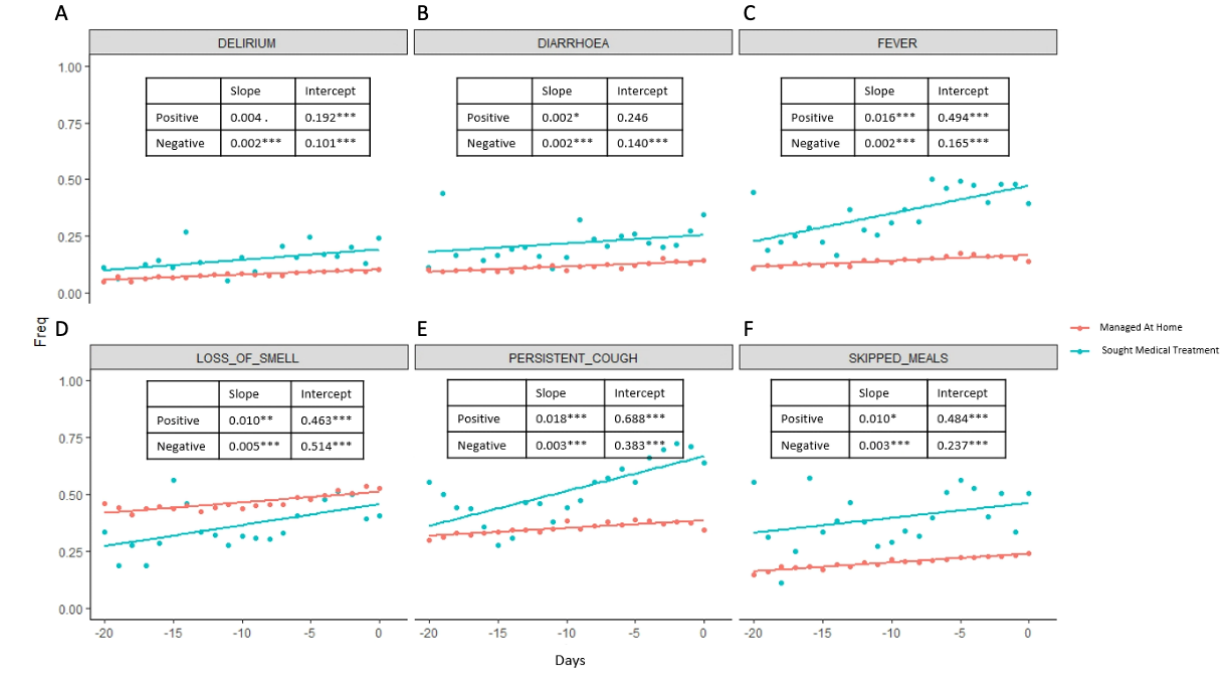
Figure 2. We analyzed all Elastic Net regression–selected symptoms for a 20-day window in a longitudinal manner, where day 0 for the positive group corresponds to the day when the user seeks treatment, and day 0 for the negative group corresponds to the last entry. The frequency of users having each feature for each day was plotted. A linear regression line where the frequency is regressed onto the days is plotted. The slopes and intercepts are labeled. Binary features of both positive and negative groups are plotted.